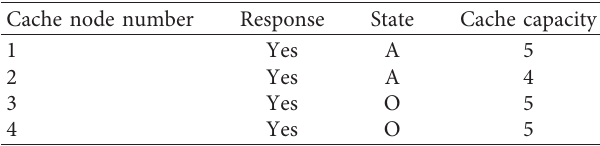
Figure 1: List of cluster headers. Table 1: Cache capacity of the cluster head in each node